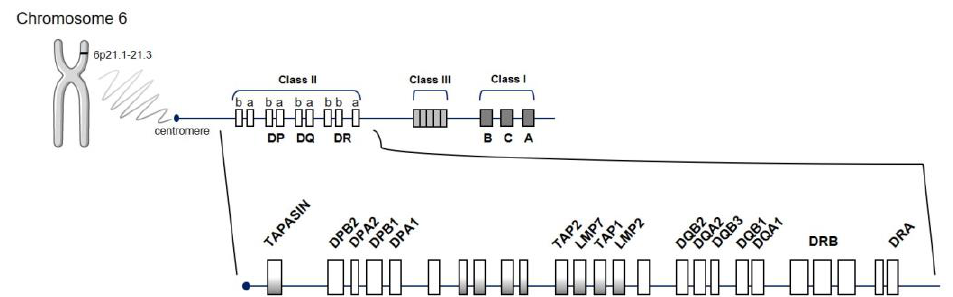
Figure 1. Schematic representation of the human leucocyte antigen (HLA) region. HLA molecules are encoded by genes located on short arm of chromosome 6 at position 6p21.1–21.3, in class I and class II regions. Abbreviations for the different genes located in the HLA complex: DPA1 and DPA2: DP alpha 1 and 2 chain, respectively; DPB1 and DPB2: DP beta 1 and 2 chain, respectively; DRA, DR alpha chain; DRB, DR beta chain; DQA1 and DQA2: DQ alpha 1 and 2 chain, respectively; DQB1 and DQB2: DQ beta 1 and 2 chain, respectively; LMP2 and LMP7, latent membrane protein 2 and 7, respectively; TAP1, transporter associated with antigen processing 1; TAPASIN, TAP-associated glycoprotein (also known as TAPBP).